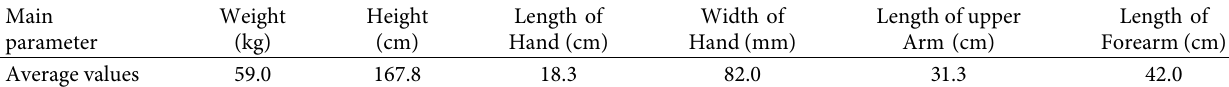
Table 3: The average anthropometric values of Chinese adult males.